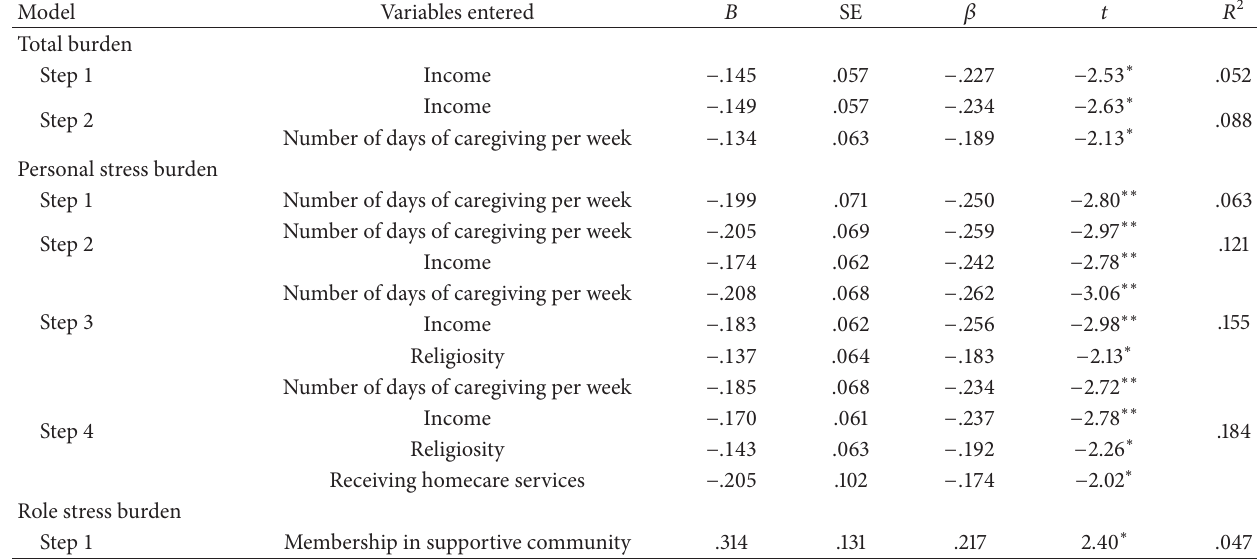
Table 5: Stepwise Regression predicting burden.